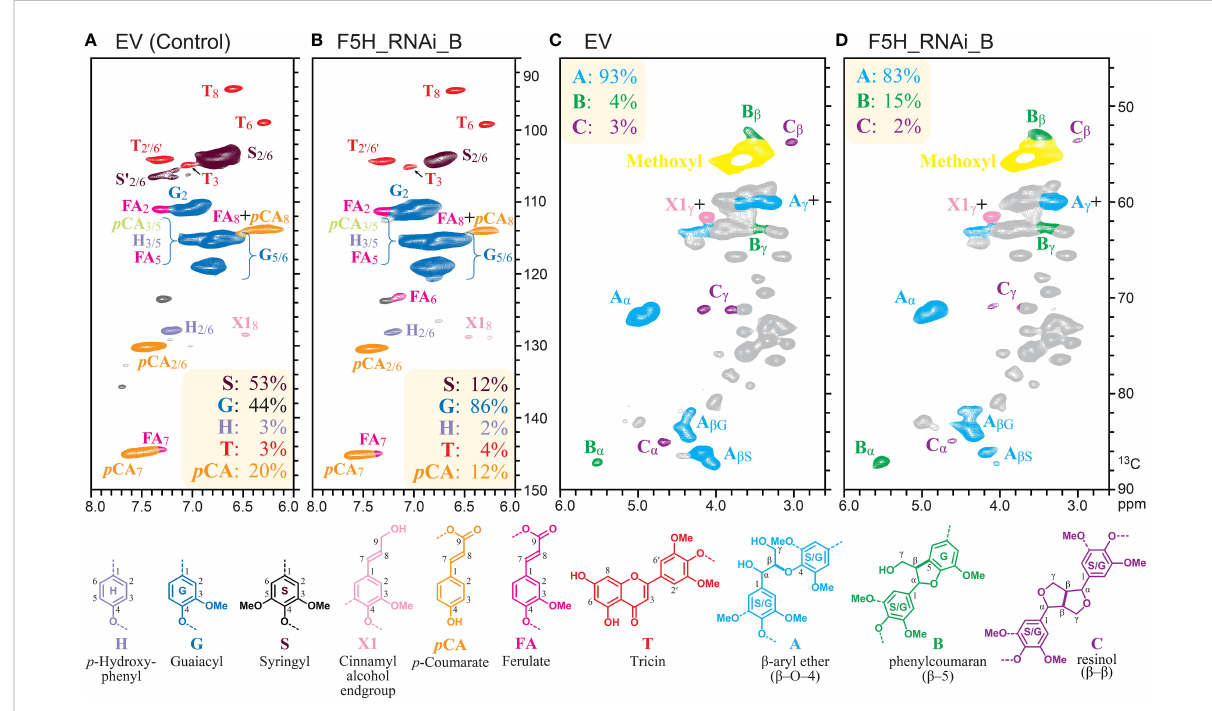
FIGURE 3 Aromatic and aliphatic subregions of 2D-NMR (HSQC) spectra of stem cell walls from HvF5H1 -RNAi plants (T2 generation) and EV. Summary data in the boxes color-coded to match their respective assignments, and represent percentages of; (A, B) major lignin subunits to the total amount of H, G, and S units; and (C, D) characterised inter-monomeric bonds to the total number of the lignin interunit